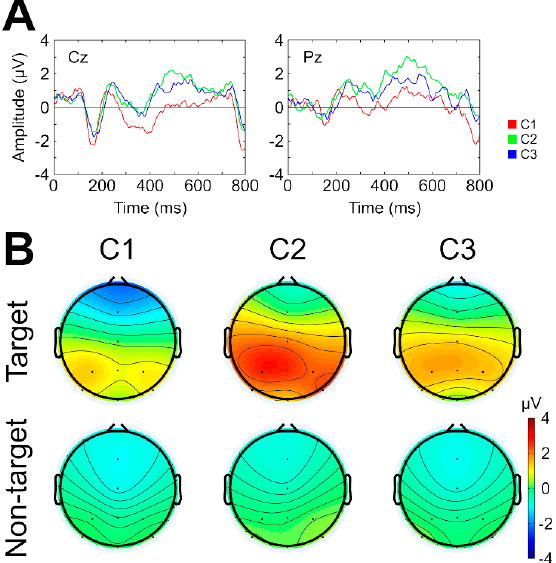
Figure 5. ( A ) Grand average event-related potential (ERP) waveform (microvolts) for target stim- uli in Cz and Pz, for the three conditions (C1, no speech; C2, ignoring the speech; C3, listening to the speech). ( B ) Topographical scalp map for the P300 component (450–550 ms) of each condition. Both plots have been obtained from the calibration